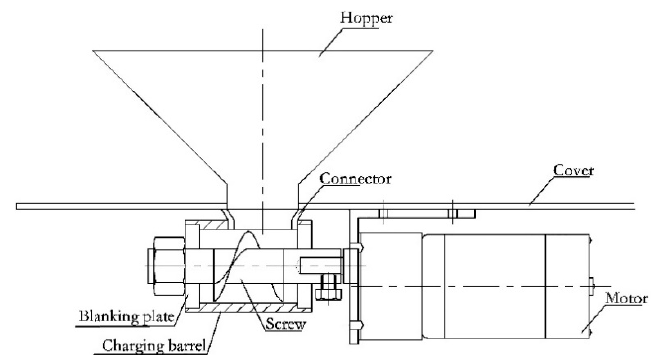
Figure 3. Structure diagram of the fertilizer-feeding component in the designed fertigation device.